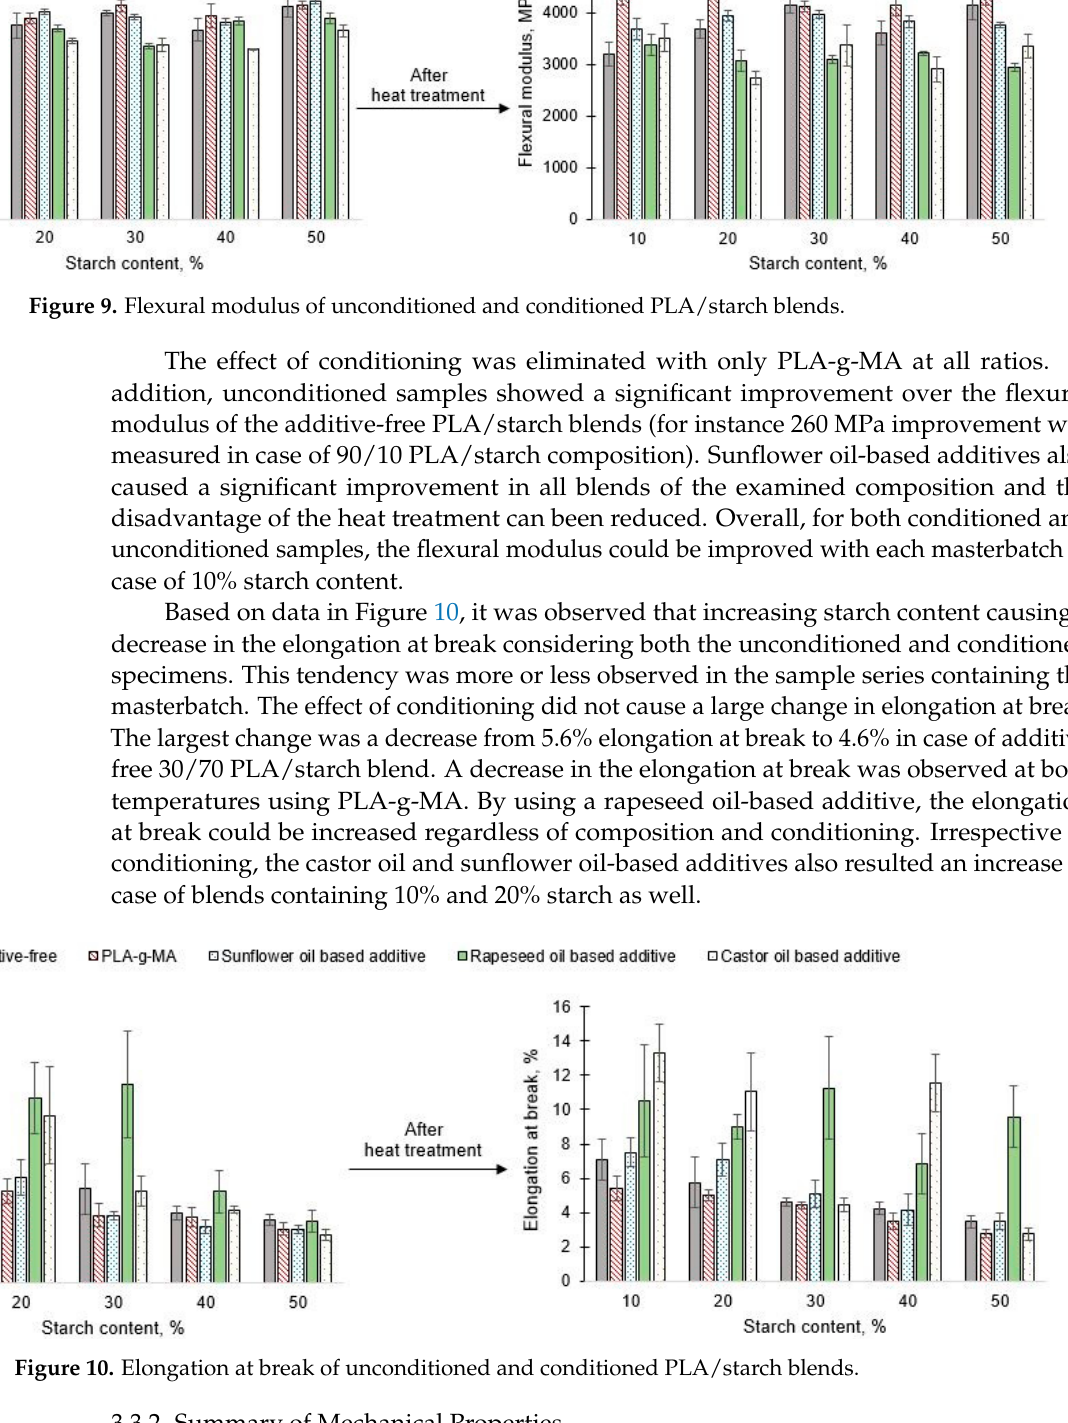
Figure 8. Tensile modulus of unconditioned and conditioned PLA/starch blends.